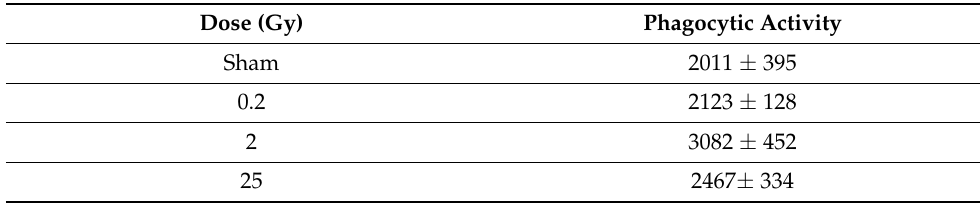
Table 1. Phagocytic activity of PLB cells Zymosan (10 6 /mL) stained with Alexa 488 were added to the PLB suspension (50 µ L each). The suspension was mixed gently and phagocytosis assay was performed at 37 ◦ C for 30 min. The phagocytic activity was expressed as (% phagocytic cells containing ≥ 1 zymosan) × (mean fluorescence of the phagocytic cells). Results are presented as the mean ± SEM of two independent experiments. Dose (Gy) Phagocytic Activity Sham 2011 ± 395